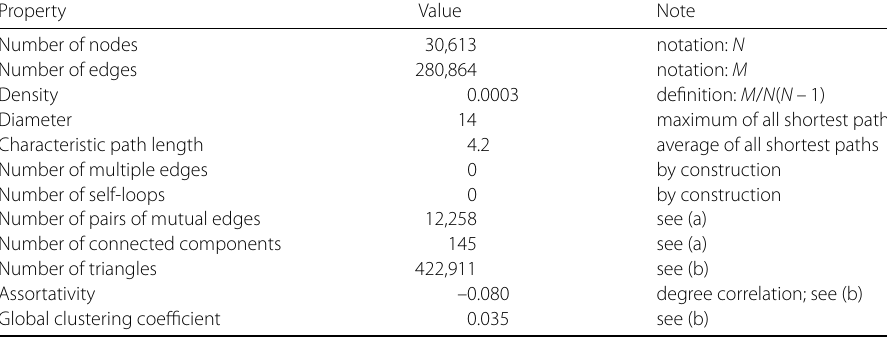
Table A.1 Summary of network properties Property Value Note Number of nodes